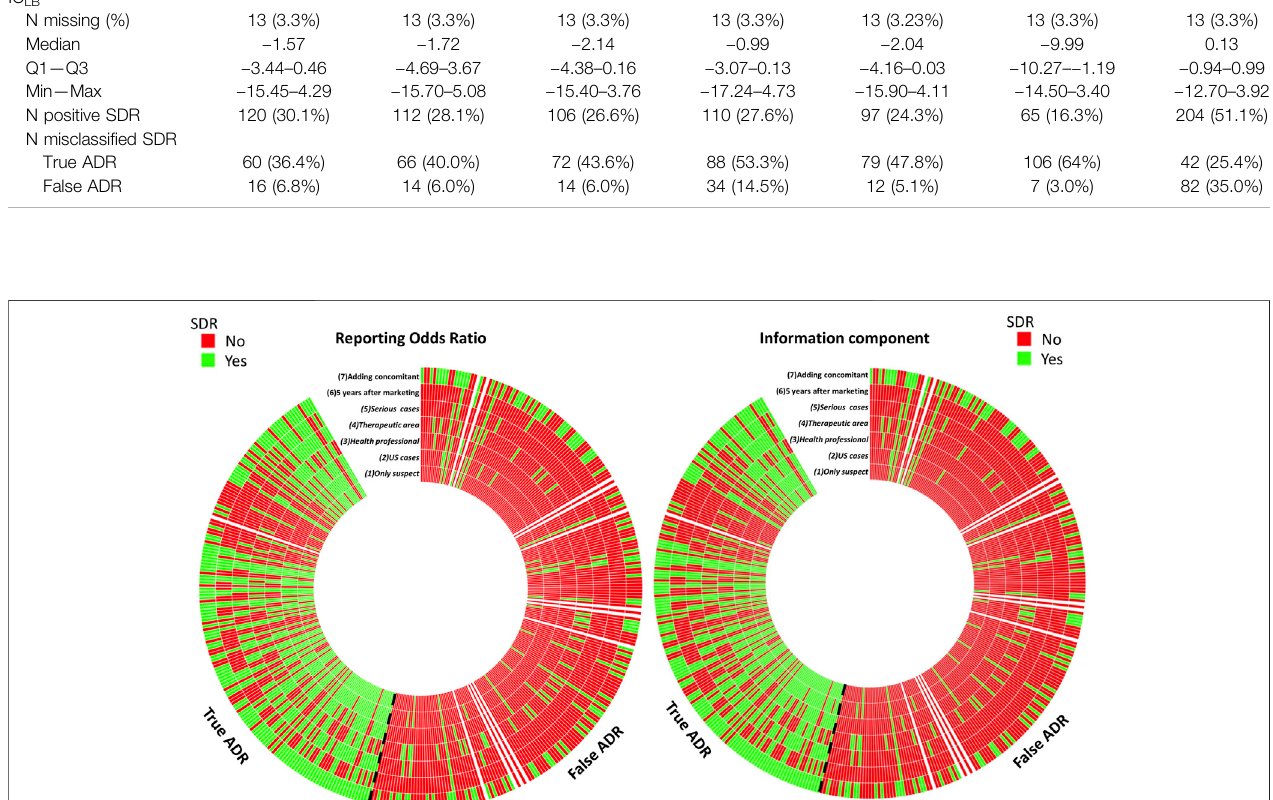
Frontiers in Pharmacology |